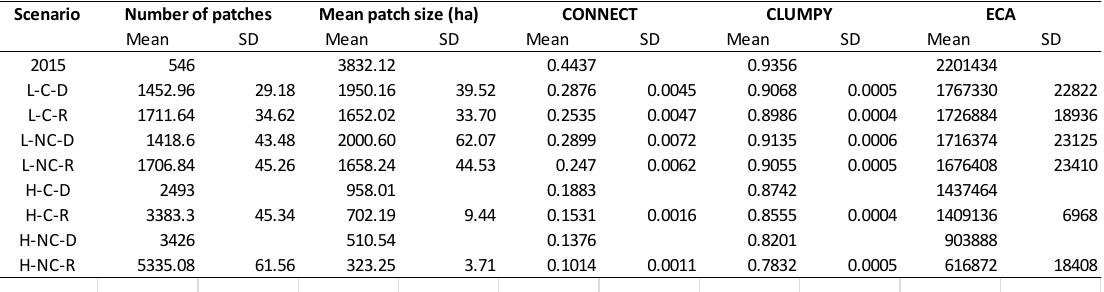
Table A3.1. Fragmentation and connectivity indices. Scenarios differ in deforestations rates (L: low, H: high), and spatial planning at the regional level (C: with corridors, NC: without corridors) and plot level (D: design, R: